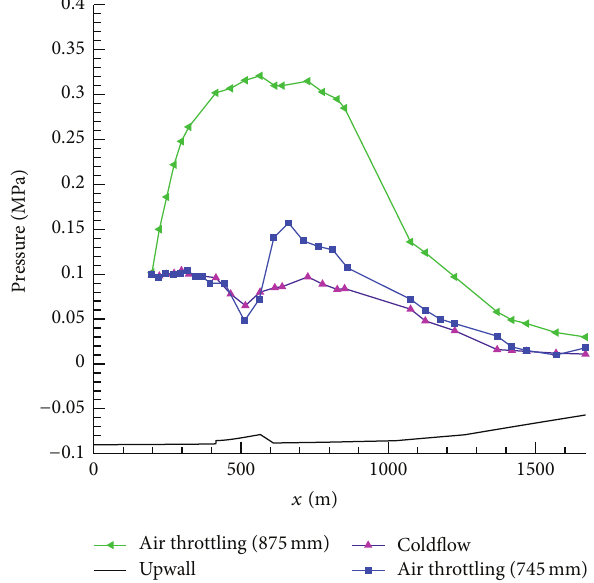
Figure 11: Wall pressure of the scramjet combustor with different air throttling location (air throttling (875 mm): the location of the air throttling was 875 mm from the entrance of the combustor; air throttling (745 mm): the location of the air throttling was 745 mm from the entrance of the combustor; coldflow: nonreacting flow of the scramjet